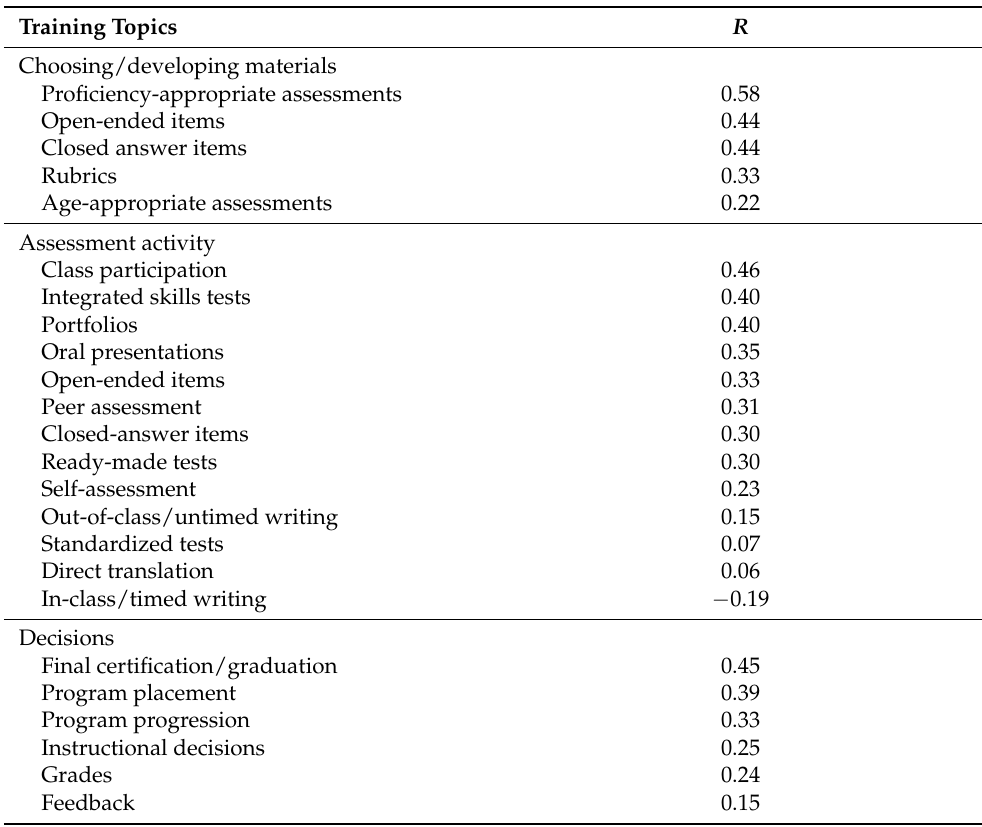
Table 8. Correlation between training and confidence